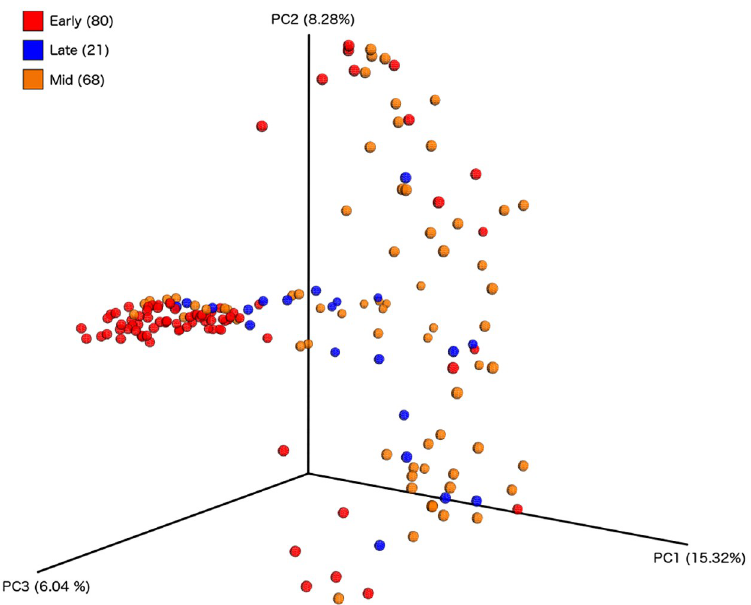
Fig 4. Principal Component Analysis showing similarity between samples from different babies at grouped timepoints. Principal Component Analysis plots based upon Bray Curtis Diversity indices for babies at grouped timepoints. Early time points (t0-t4, n = 80) are shown in red, middle time points (t5-t8, n = 68) in orange and late time points (t9-10, n = 21) in blue. Statistical testing of sample stratification (adonis test) showed significant clustering by age both when broadly grouped, and when more finely grouped by months (p = 0.001 for both tests).